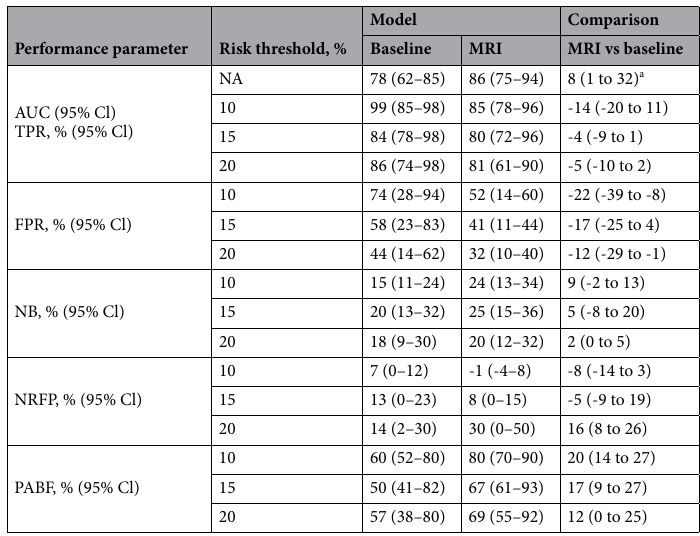
Table 4. Performance of the two Risk Prediction Models in the Research Cohort. NA not applicable; NB net benefit; NRFP net reduction in false-positives; PABF percentage of avoided biomedical failures; percentage of avoided biopsies; TPR true-positive. rate. a P < 0.05 for the comparison of